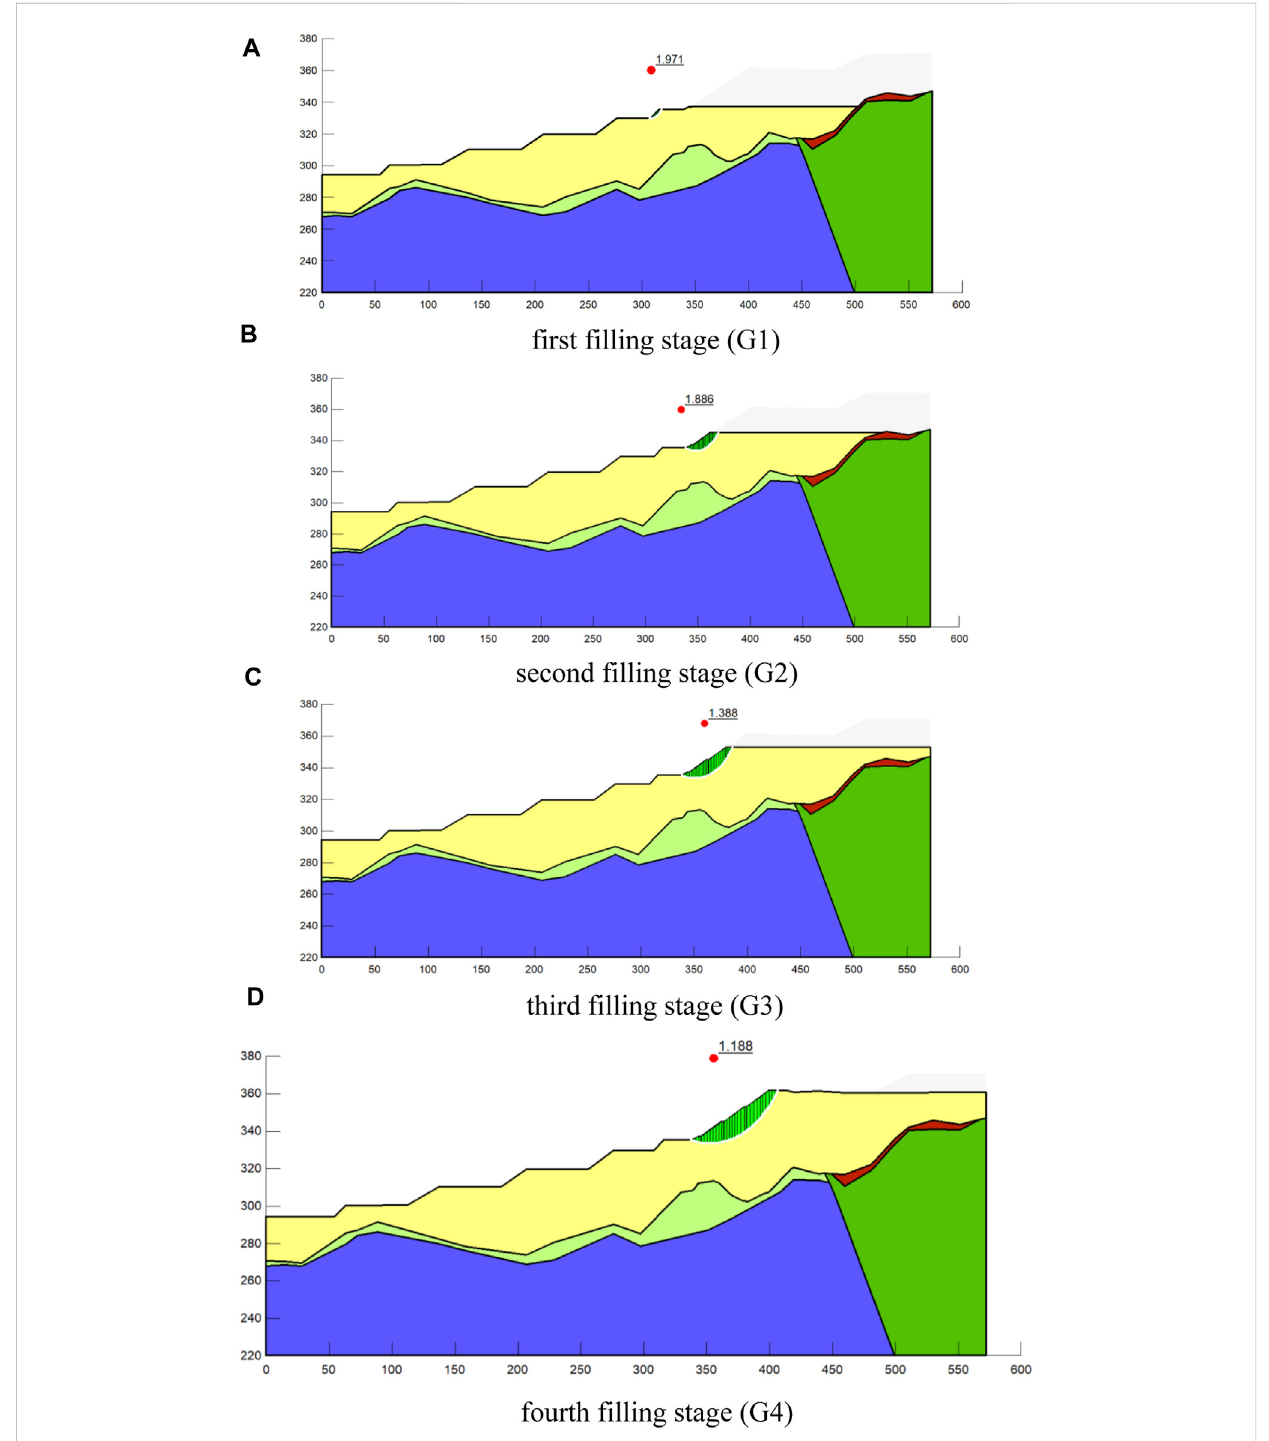
FIGURE 14 Potentialslidingsurfacesofthehigh- fi lledslopeduringtheGarea fi llingprocess: (A) fi rst fi llingstage(G1); (B) second fi llingstage(G2); (C) third fi lling stage (G3); (D) fourth fi lling stage